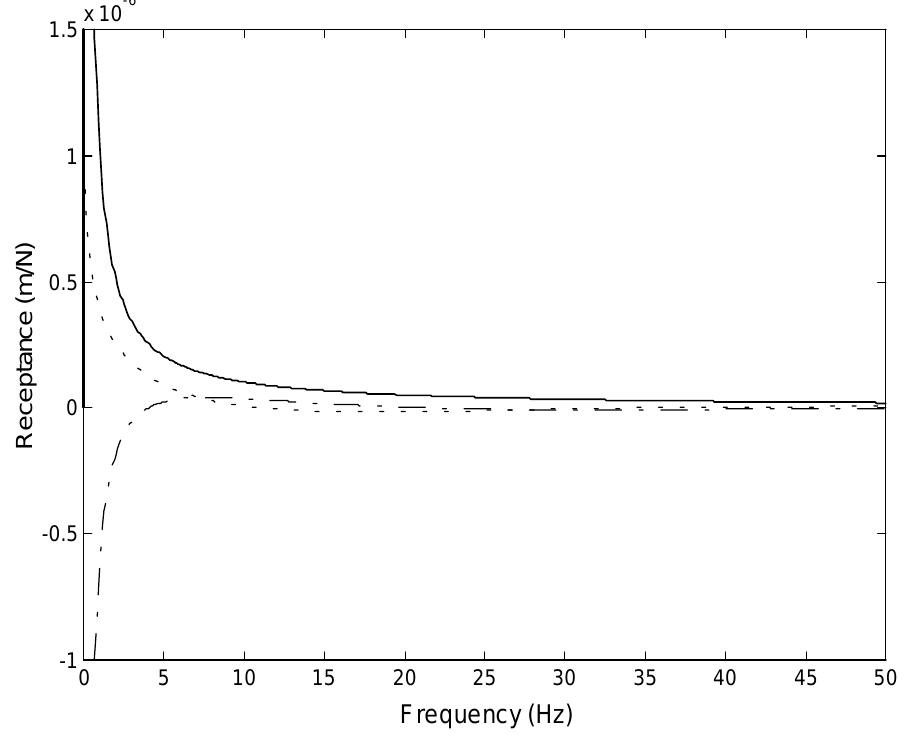
Fig. 8. The comparison of real and imaginary parts of receptance with the variation of frequency under the light fluid loading. The distance from driving point is 4 m with plate thickness 0.04 m. —, point receptance (pure imaginary); − − -, real part of transfer receptance; − - − , the imaginary part of transfer